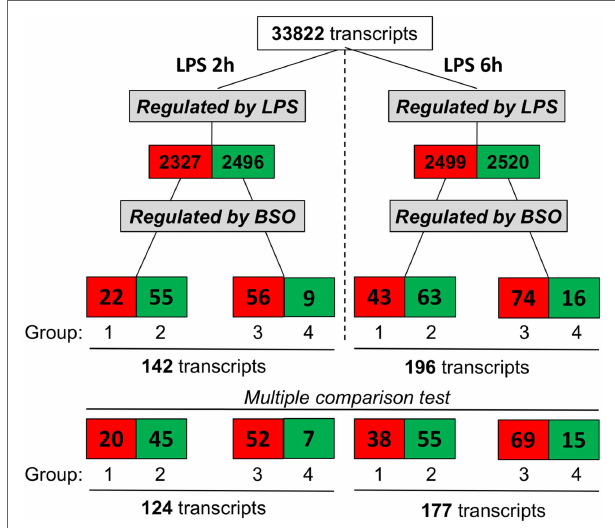
FigUre 2 | Effect of GSH depletion on LPS-induced changes in gene expression profile. The dataset was filtered to select transcripts that were affected by LPS (LPS vs control, first step), then by BSO (BSO + LPS vs LPS alone, second step) . Cutoff for selection was 1.5-fold change and P < 0.05, using the Student’s t -test. Significantly different expressed genes were further selected by using one-way ANOVA, followed by a correction for multiple comparisons by controlling the false discovery rate with the two-stage step-up method of Benjamini, Krieger, and Yekutieli. The number of transcripts resulting from filtering is indicated and color coded (red, increased; green, decreased). ANOVA, analysis of variance; BSO, buthionine sulfoximine; GSH, glutathione; LPS,